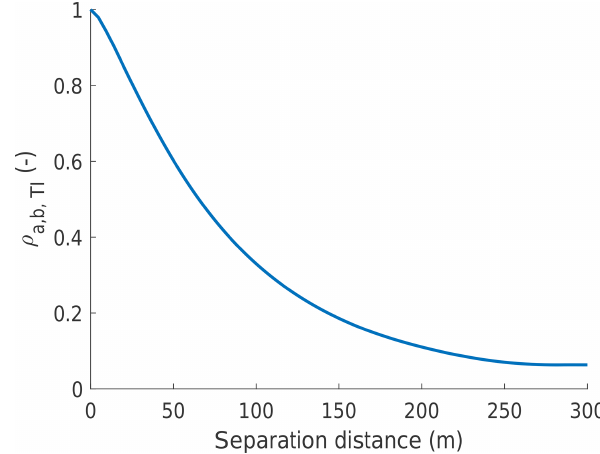
Figure 7. Impact of horizontal cross-flow separation distance be- tween points a and b on correlation coefficient of turbulence inten- sity between these